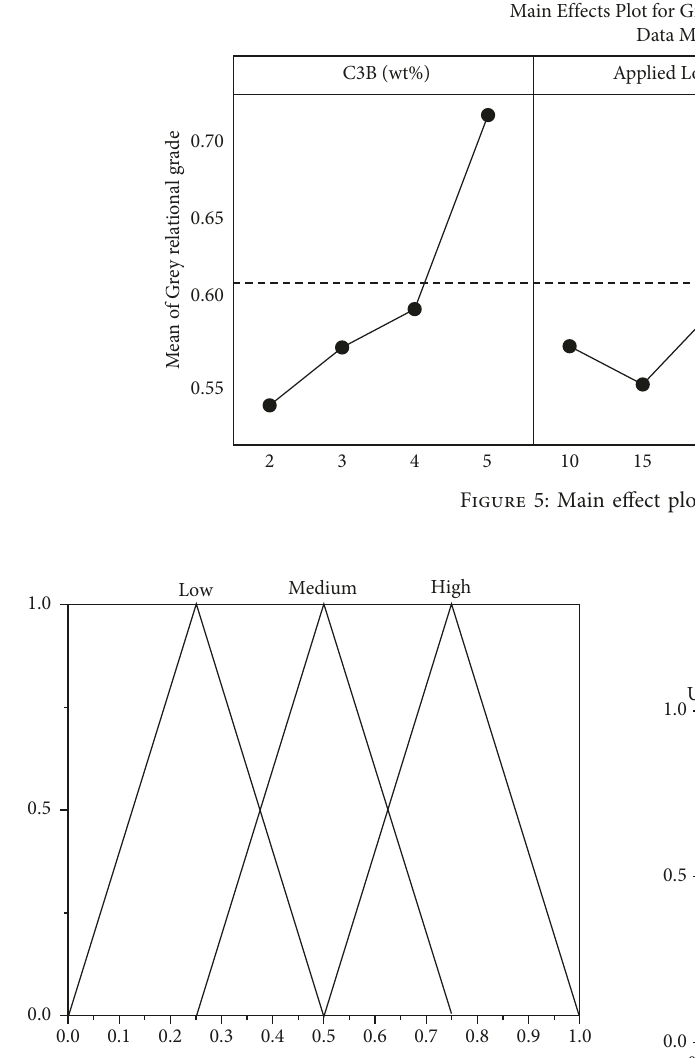
Figure 6: Output characteristics like weight loss, coefficient of friction, and specific wear rate. Figure 7: The nine fuzzy subsets for grey fuzzy reasoning